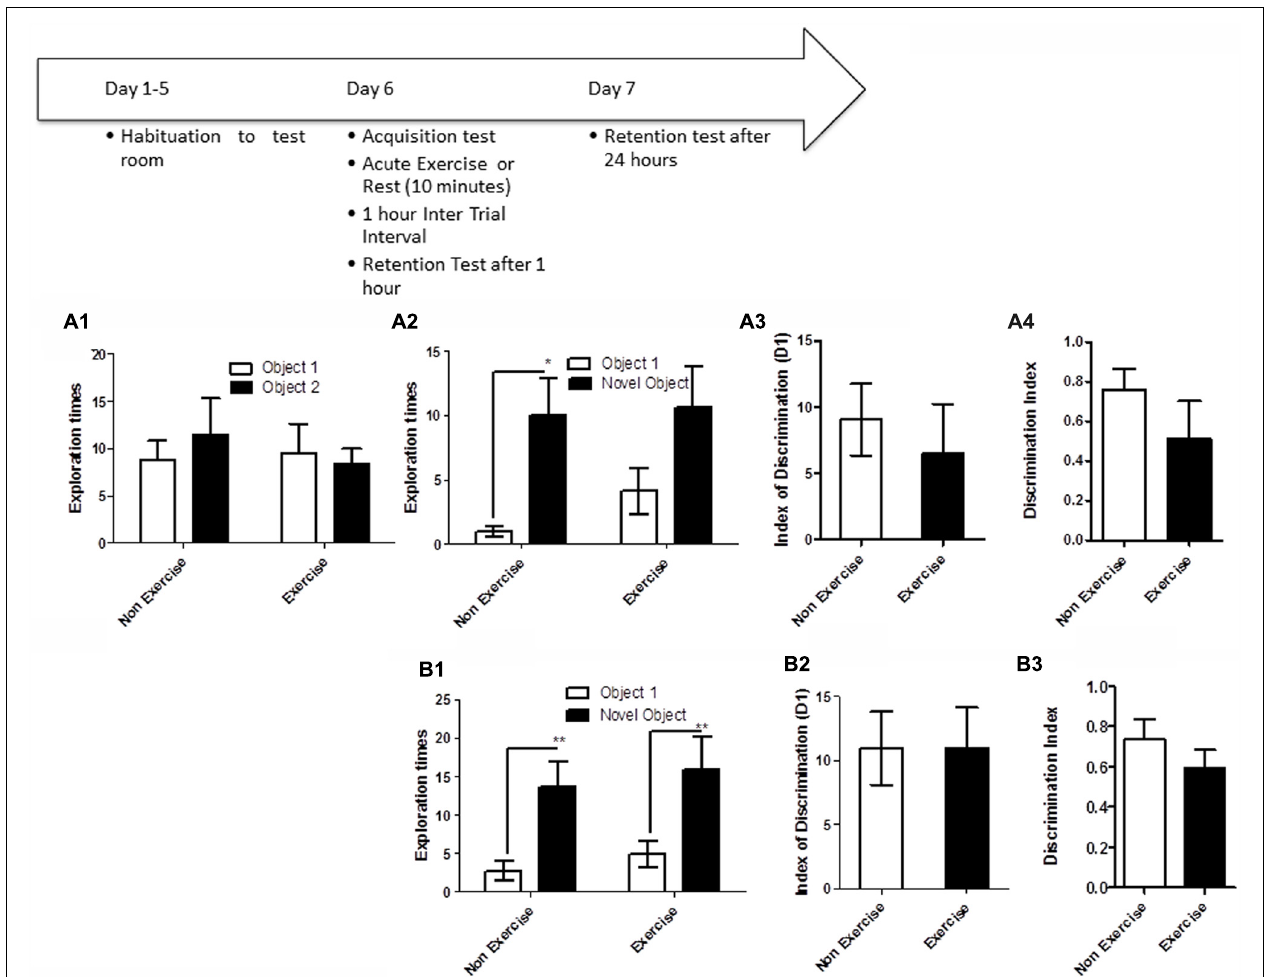
quite significant. (A3) The index of discrimination did not show any significant difference between the two groups, 1 h after the exercise suggesting that both groups performed similarly on the task. (A4) Discrimination index also did not differ between the two groups, 1 h after the exercise. * p < 0.05. Significant increase in exploration of the novel object compared to familiar object in control animals. n = 8/group. Error bars show ± SEM. (B1) Twenty-four hour after the 10 min exercise regimen both the exercise and control groups showed significantly greater exploration of the novel object compared to familiar object. ** p < 0.01. Significant difference between novel and familiar object exploration. (B2) The index of discrimination showed no significant difference between the two groups 24 h after exercise suggesting that both groups successfully discriminated the novel object from the familiar object. (B3) Discrimination index showed no significant difference between the two groups, 24 h after exercise. n = 7–8/group. Error bars show ±